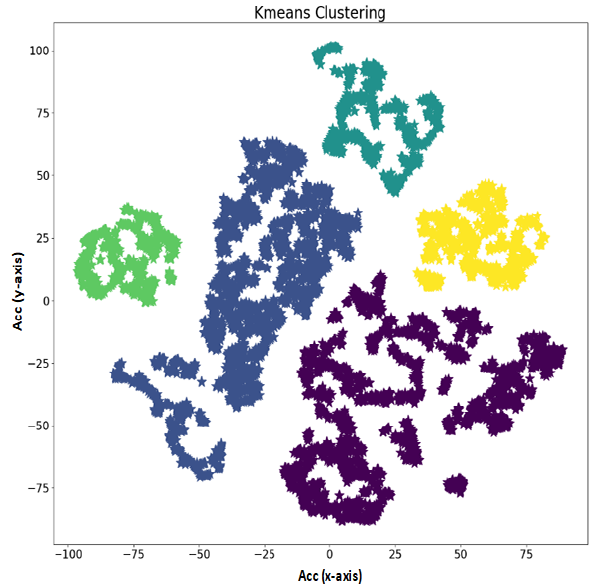
Figure 7. Clustering of IMU sensor